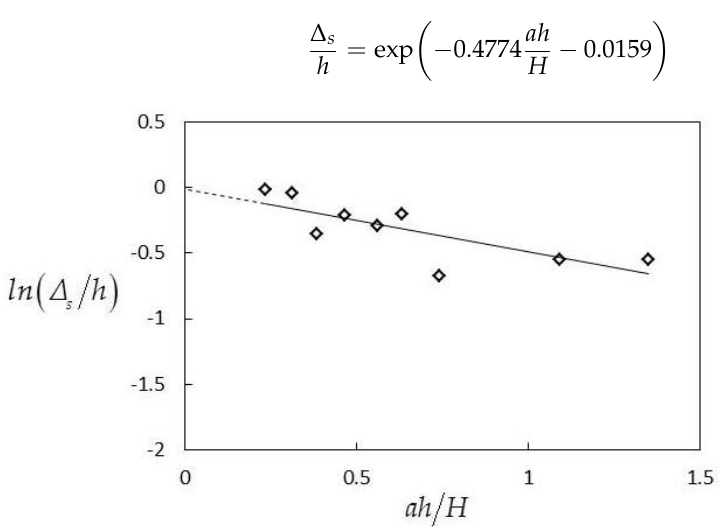
Figure 5. Height of the theoretical zero point Δ s varies with the comprehensive parameter ah/H .